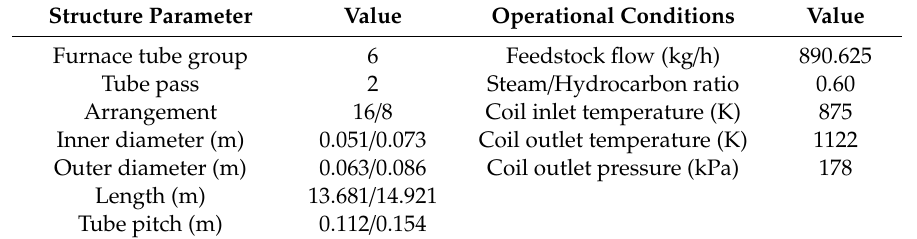
Table 5. Structural parameters and operational conditions of type SL (Sinopec & Lummus)-1 thermal cracking furnace [21].